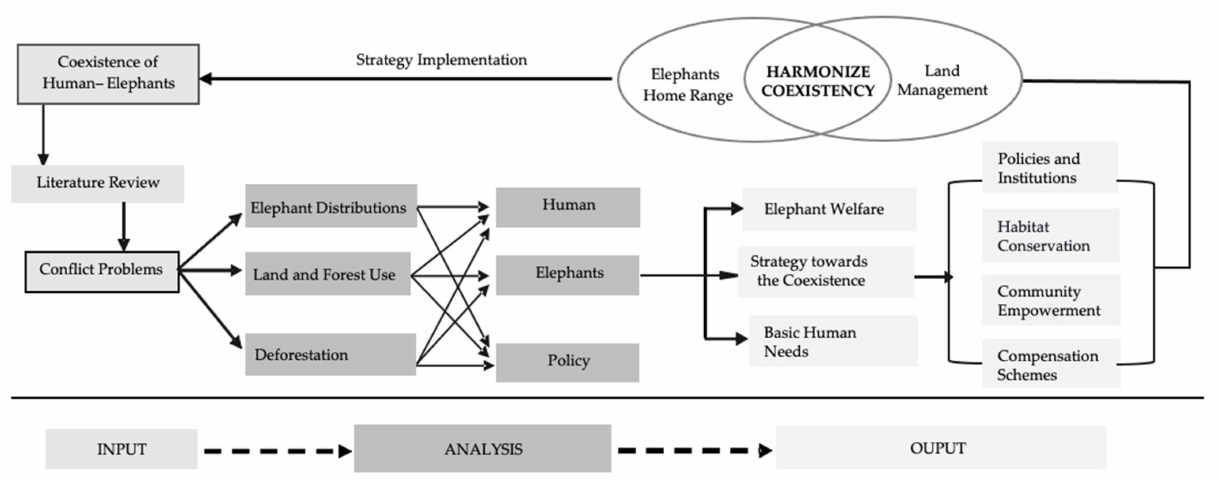
Figure 1. Conceptual framework of the